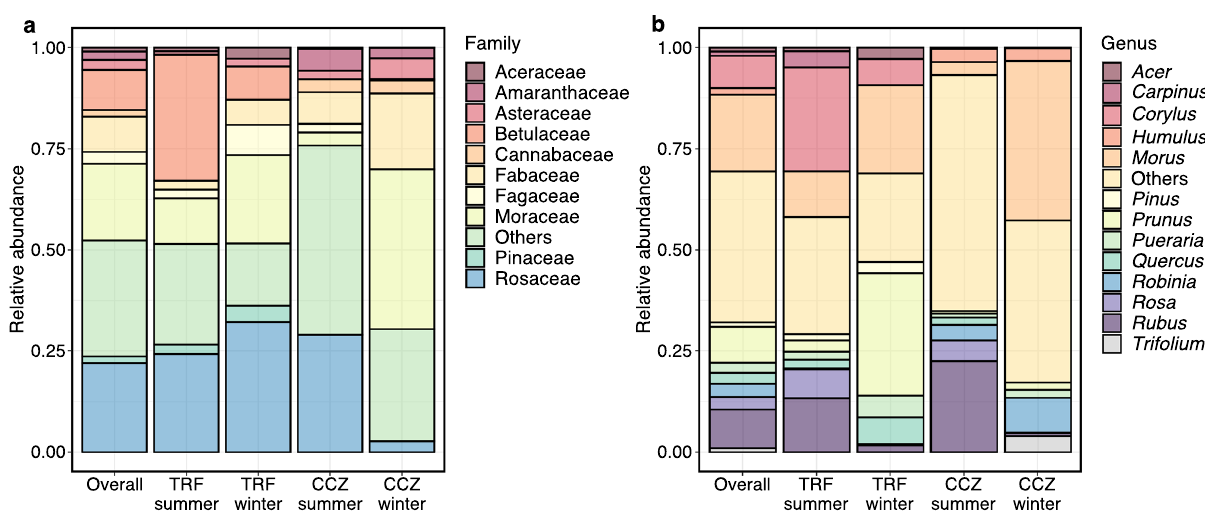
Figure 2. Relative abundance of plants at ( a ) family and ( b ) genus levels. The mean relative abundance of samples in each group is shown. The families and genera with more than more than 1% of relative abundance are